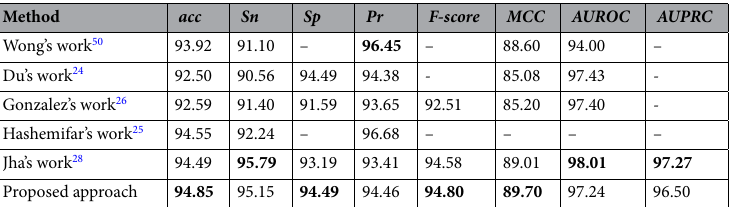
Table 10. Comparative analysis of the proposed approach with existing methods for S. cerevisiae dataset. Best values are in